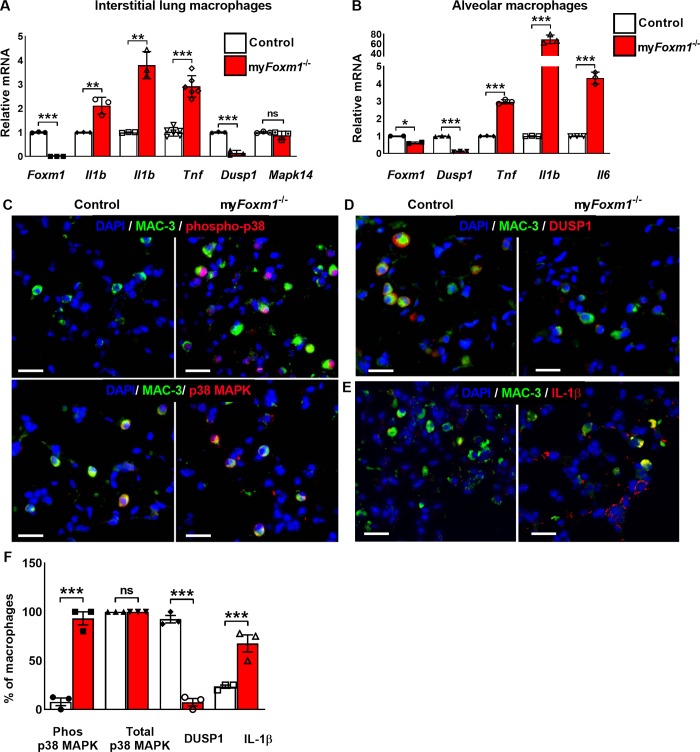
Deletion of Foxm1 from macrophages induces activation of p38 MAPK pathway.(A-B) Interstitial and alveolar macrophages were isolated from bleomycin-treated myFoxm1-/- and control lungs using FACS sorting. qRT-PCR shows decreased Foxm1, and Dusp1 mRNAs and increased Tnf, Ccl5, Il1β, and Il6 mRNAs in flow-sorted interstitial and alveolar macrophages from bleomycin-treated myFoxm1-/- mice. Actb mRNA was used for normalization. N = 3 mice per group. (C) Increased expression of phosphorylated p38-MAPK (red) in MAC-3+ (green) macrophages was shown in bleomycin-treated myFoxm1-/- mice compared to control (upper panels). No difference in total p38-MAPK (red) was observed in macrophages in bleomycin-treated myFoxm1-/- mice compared to control (lower panels). (D) Co-localization studies showed decreased expression of DUSP1 (red) in MAC-3+ (green) macrophages in bleomycin-treated myFoxm1-/- mice. (E) Co-localization studies show increased expression of IL-1β (red) in MAC-3+ (green) macrophages in bleomycin-treated myFoxm1-/- mice. Scale bar = 50μm. (F) Percent of phospho-p38+/MAC3+, Total p38+/MAC3+, DUSP1+/MAC3+ and IL-1β+/MAC3+ double positive cells were counted in 5 random fields and presented as mean ± SEM. N = 3 mice per group. *P <0.05, **P <0.01, ***P <0.001 by Student’s t-test.